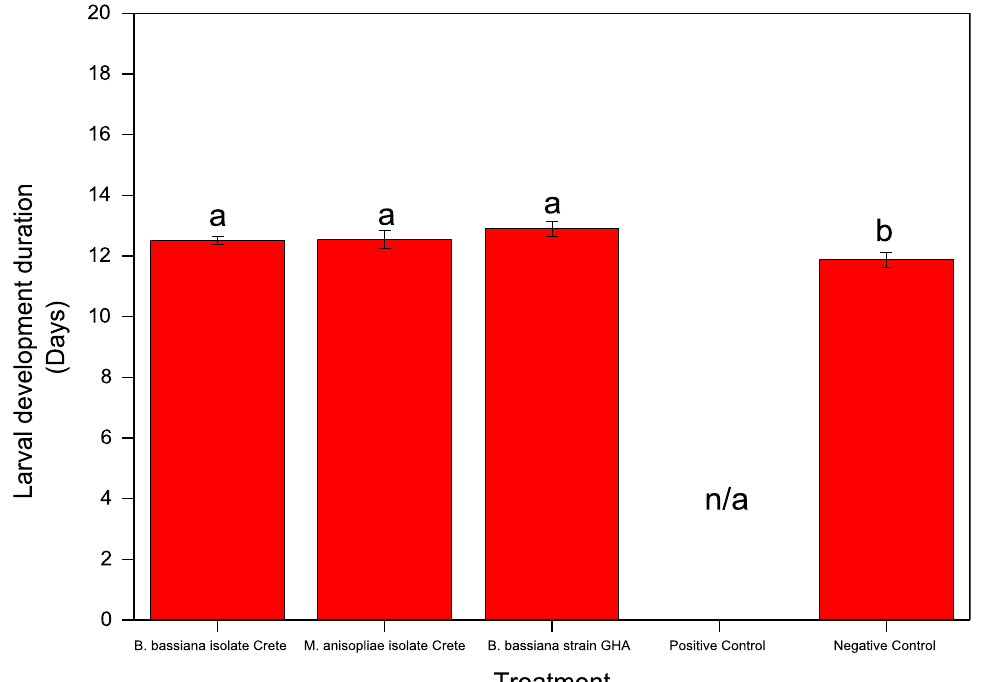
Fig. 3 Means ( se) of larval development duration in fungi‑free (control) plants and plants colonized by Beauveria bassiana isolate Crete and ± Metarhizium anisopliae isolate Crete and B. bassiana strain GHA after 15 DPI* (days per irrigation). Means of the same column followed by the same letter are not significantly different (HSD, p <